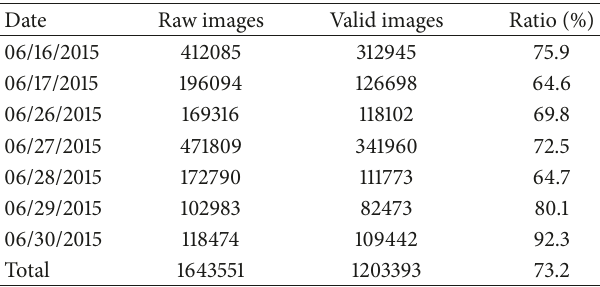
Table 3: Image data from seven rainfall